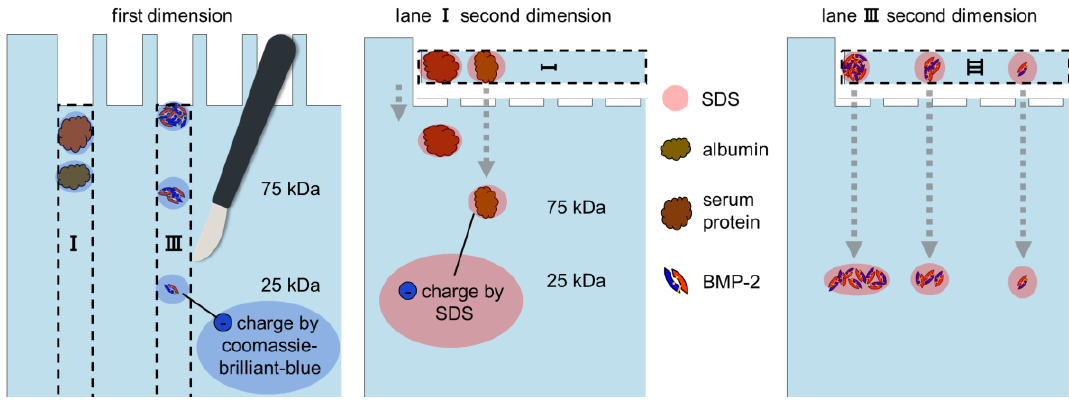
Figure 1. Illustration of the principle of a 2D Blue Native/SDS-PAGE showing the separation of BMP-2 aggregates and the separation of BSA (serum fraction V).